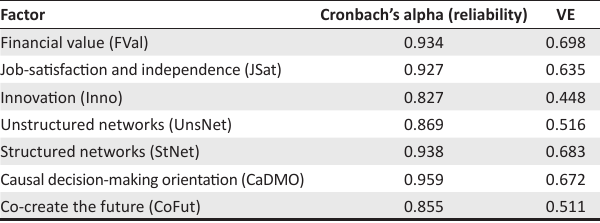
TABLE 2: Cronbach’s alpha coefficients and variance extracted of all factors. Factor